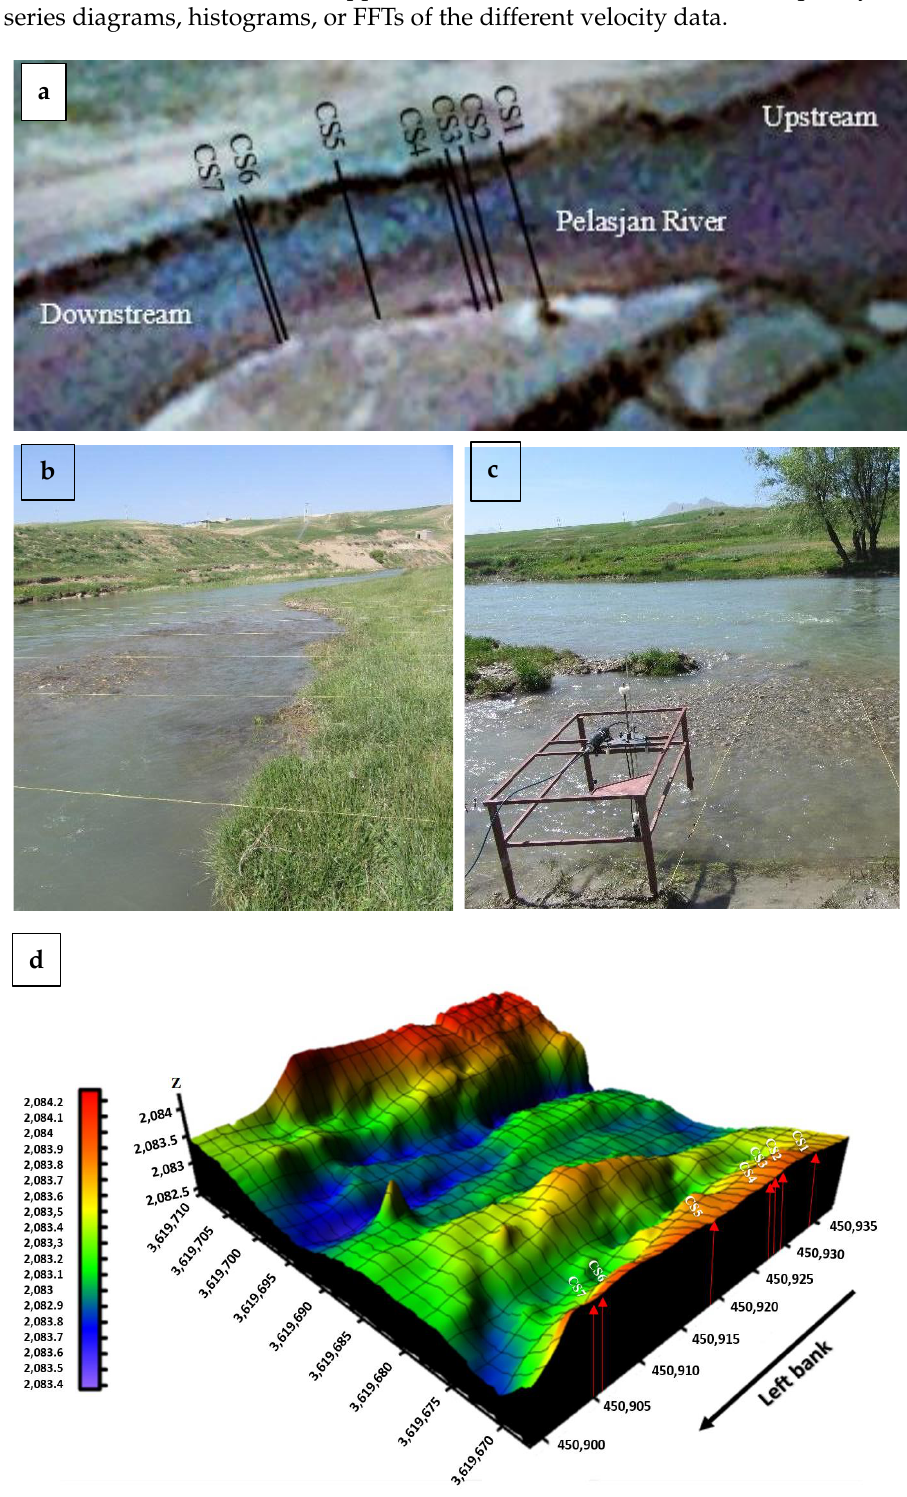
Figure 2. ( a ) The selected reach and cross-sections of the Pelasjan River, ( b ) rectangular grid and mapping operations, ( c ) ADV deployment in the river to collect velocity data, and ( d ) topographic map of the Pelasjan River in the study area (in x,y,z direction, all units are meters). This study used the Wolman method to determine the grain size distribution [17 – 20].